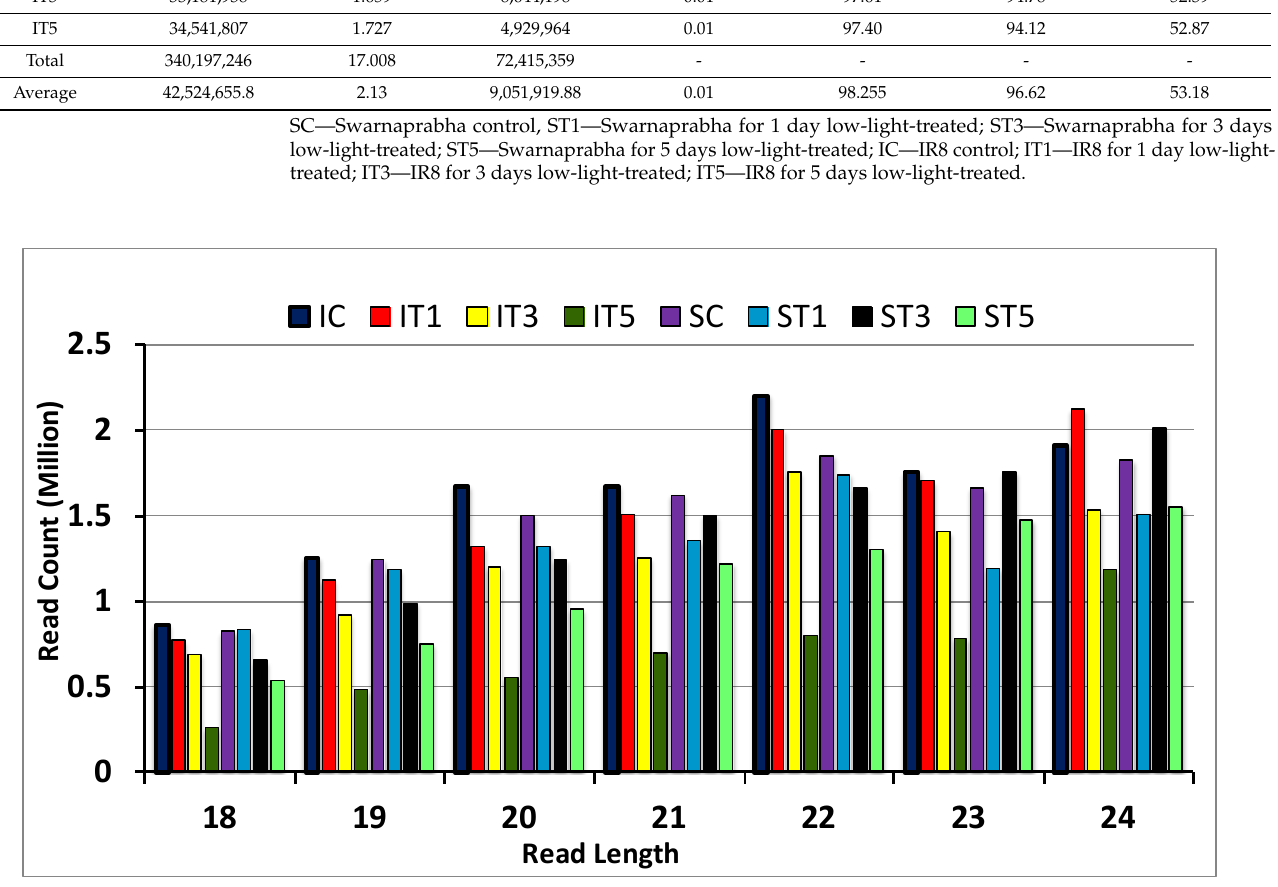
Figure 2. Read length (in nucleotide) distribution of miRNA (Illumina sequencing data) of Swarnaprabha (S) and IR8 (I) in low-light-treated T1, T3 T5, and control (C) samples. IC-IR8 control (untreated); IT1-IR8 for 1 day low-light-treated; IT3-IR8 for 3 days low-light-treated; IT5-IR8 for 5 days low-light-treated; SC—Swarnaprabha control (untreated); ST1—Swarnaprabha for 1 day low-light-treated; ST3—Swarnaprabha for 3 days low-light-treated; ST5—Swarnaprabha for 5 days low-light-treated.